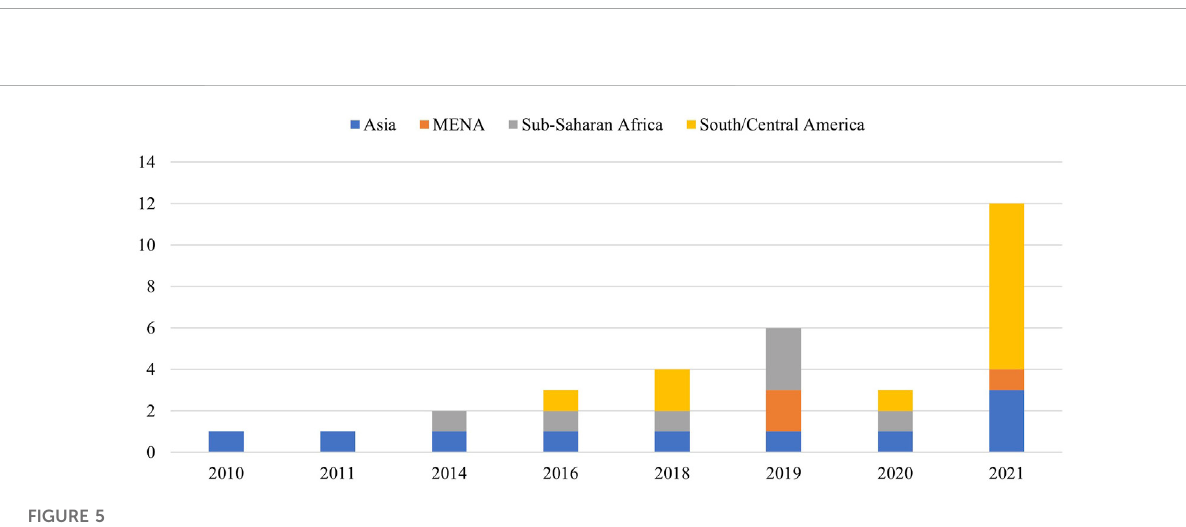
FIGURE 4 The geographical scope of the publications identi fi ed in the systematic review. Source: Authors ’ diagram using Microsoft Excel map builder. Note: Some publications cover more than one country.